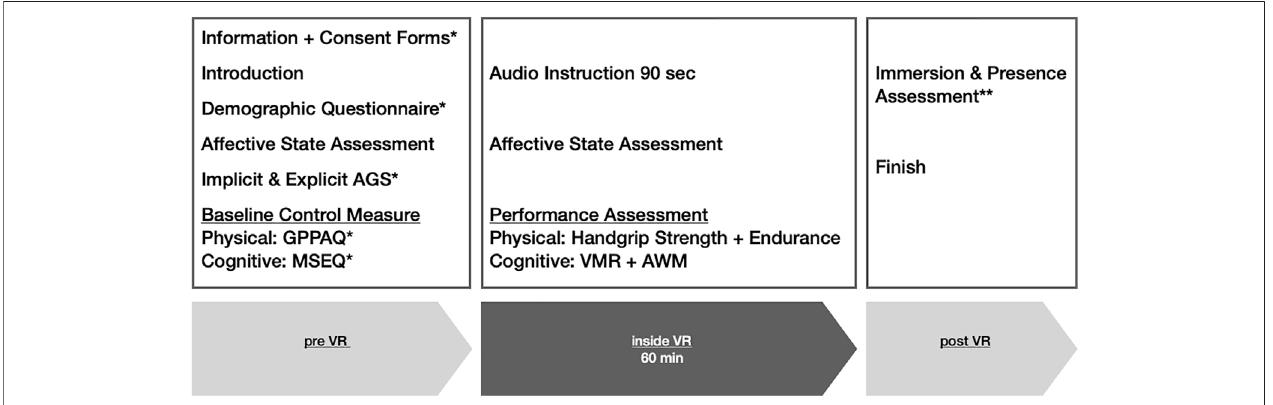
FIGURE 3 | General procedure. Note. Studies 1 and 2 consisted of either the physical or the cognitive performance focus, containing only the baseline and performance assessments of one performance domain as mentioned above. Study 3 included both performance domains into the procedure. * For Study 3 some questionnaireswerecompletedinapaper-pencilsettingpriortothelaboratoryappointment.**TheimmersionandpresenceassessmentwasonlycarriedoutinStudies 1 and